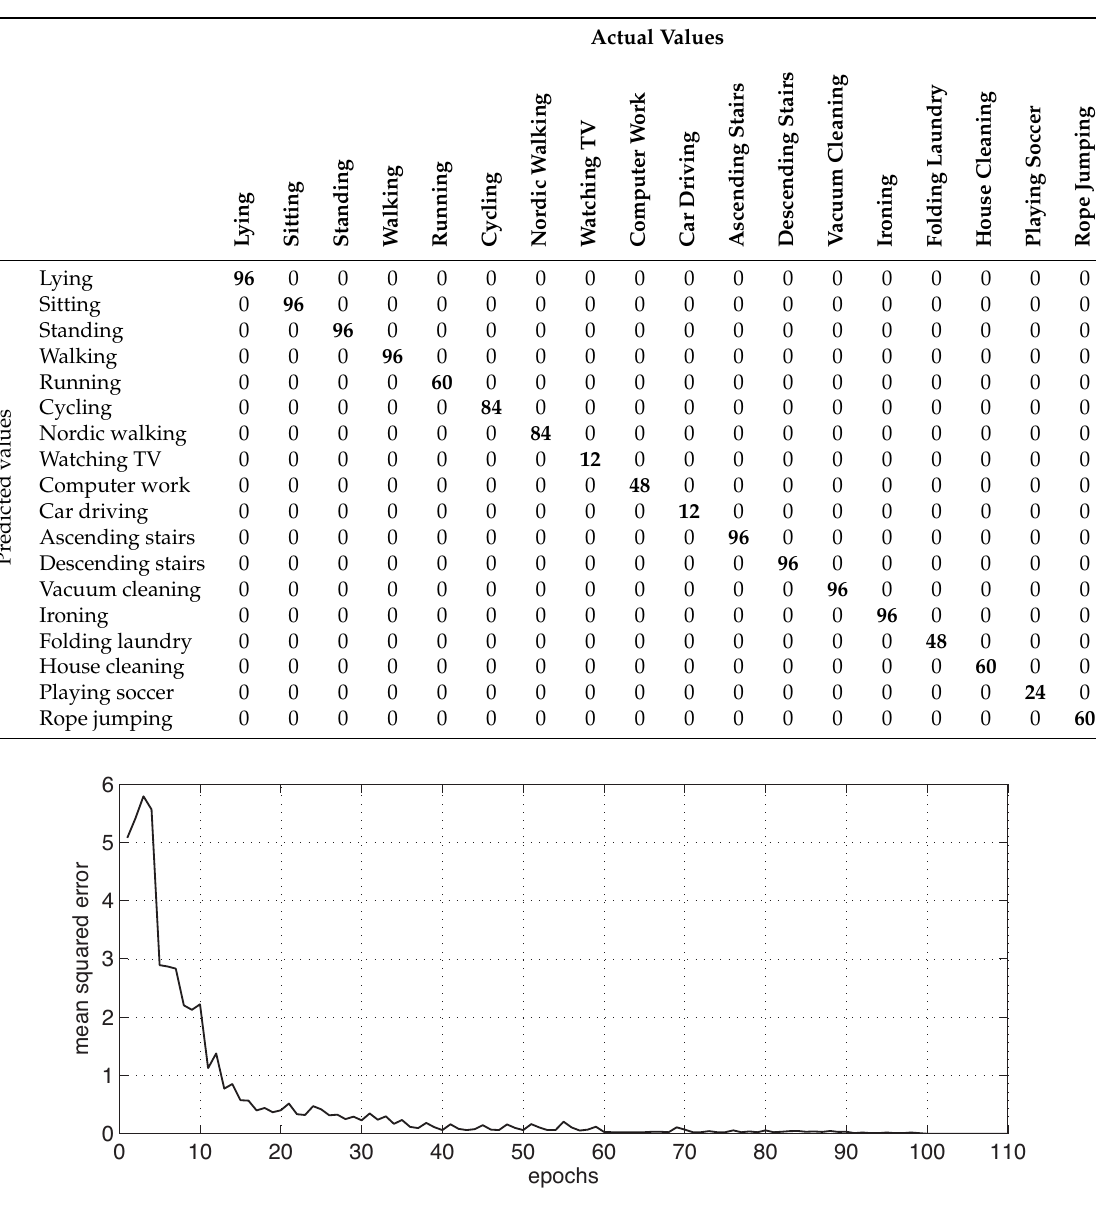
Figure 6. Learning curve of the AHN classifier for the windowing-based